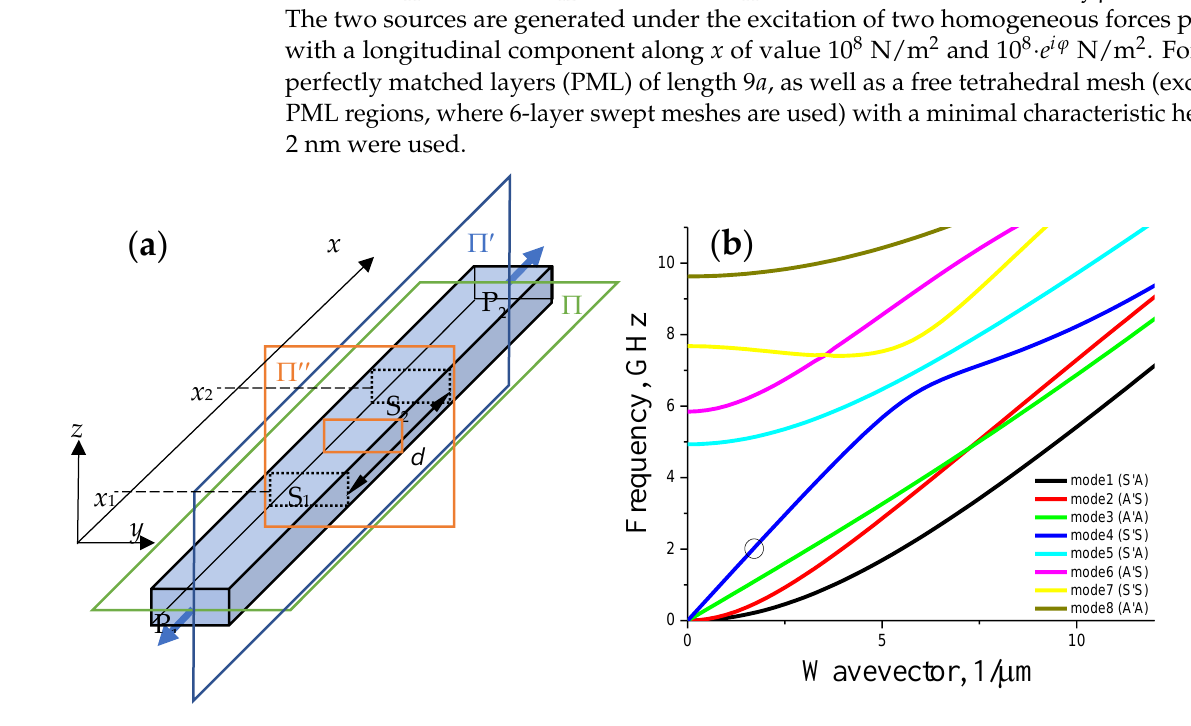
Figure 3. ( a ) Representation of the simple nanobeam of section ( a × e ) , the symmetry planes and the relative position of the two sources S1 and S2, distant of d. ( b ) Dispersion curve of the silicon nanobeam of section ( a × e ) = (500 nm × 220 nm). The symmetry (S) or anti-symmetry (A) of the mode is indicated with respect to the ( Π (cid:48) , Π ) plane.